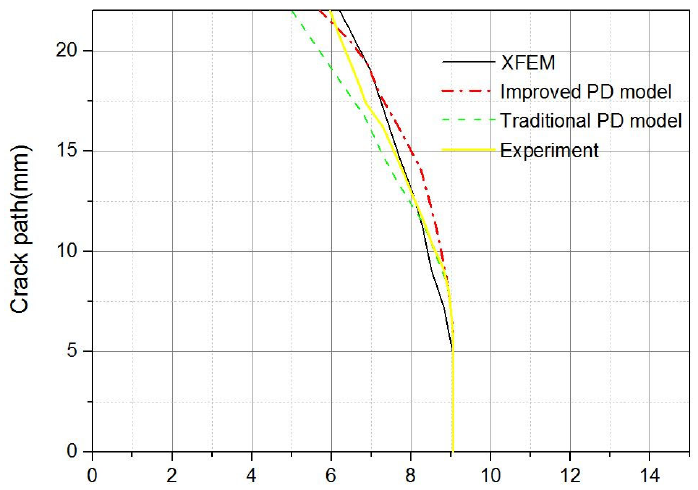
Figure 11. Crack path diagram.